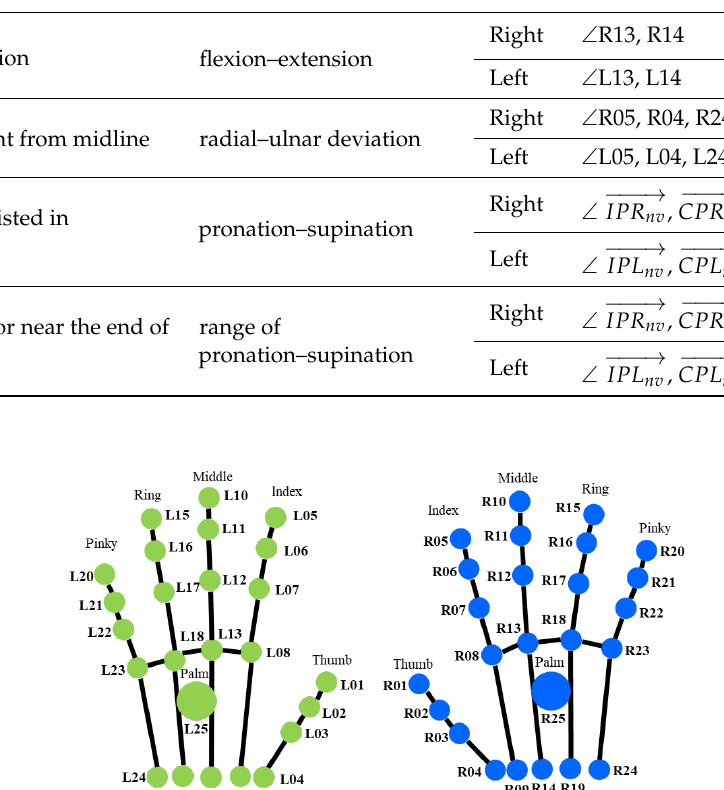
Table 3. RULA wrist posture scoring criteria.